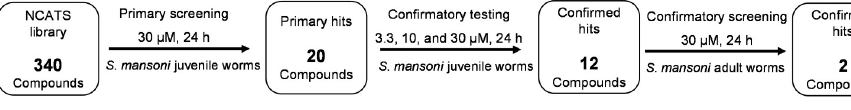
Fig 4. Description of the screening